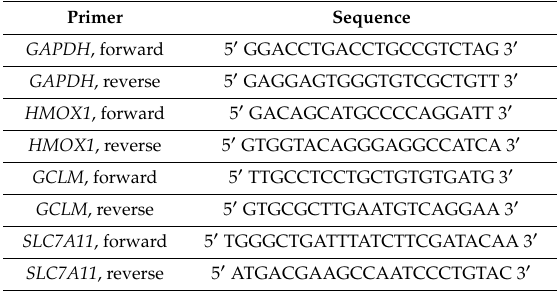
Table 1. Primer pairs for PCR of characteristic Nrf2-dependent genes and GAPDH housekeeping gene.